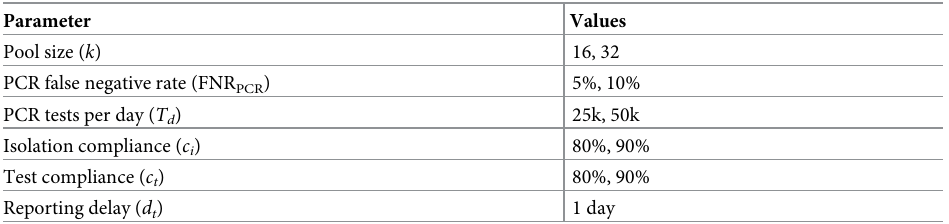
Table 2. Overview of the model parameters related to the universal testing